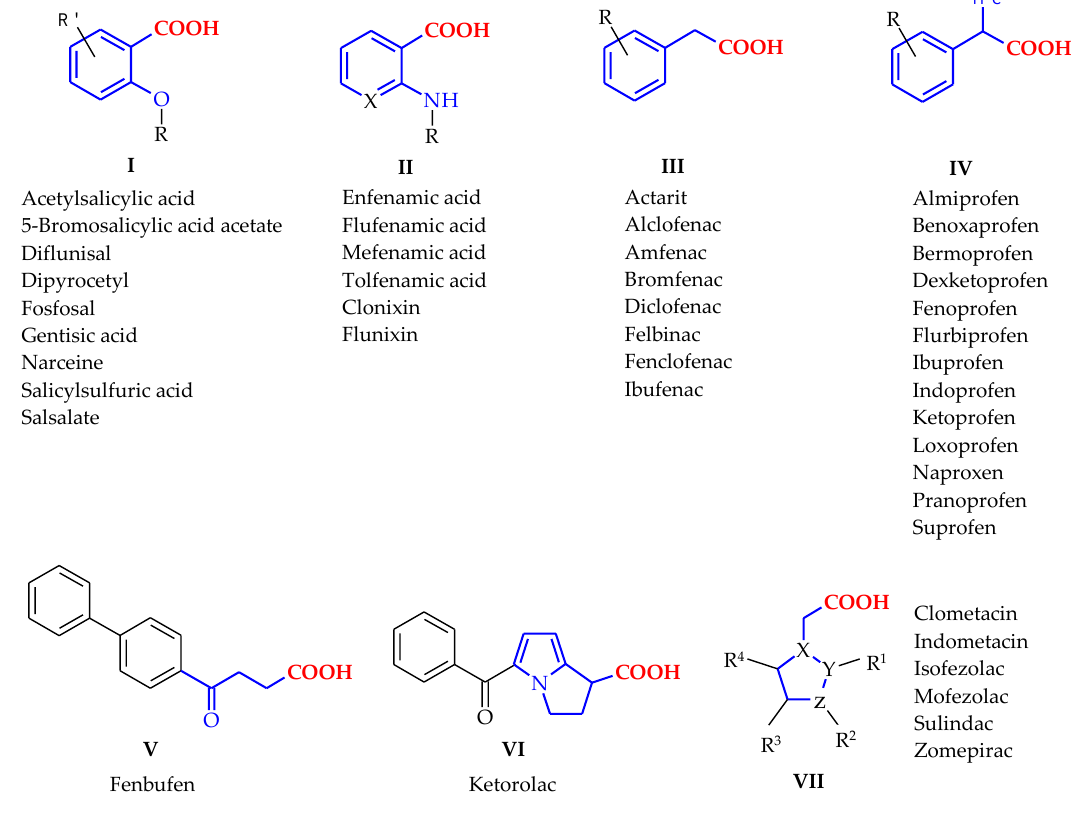
Figure 1. Analgesic-acids that are officially registered drugs [1,2].